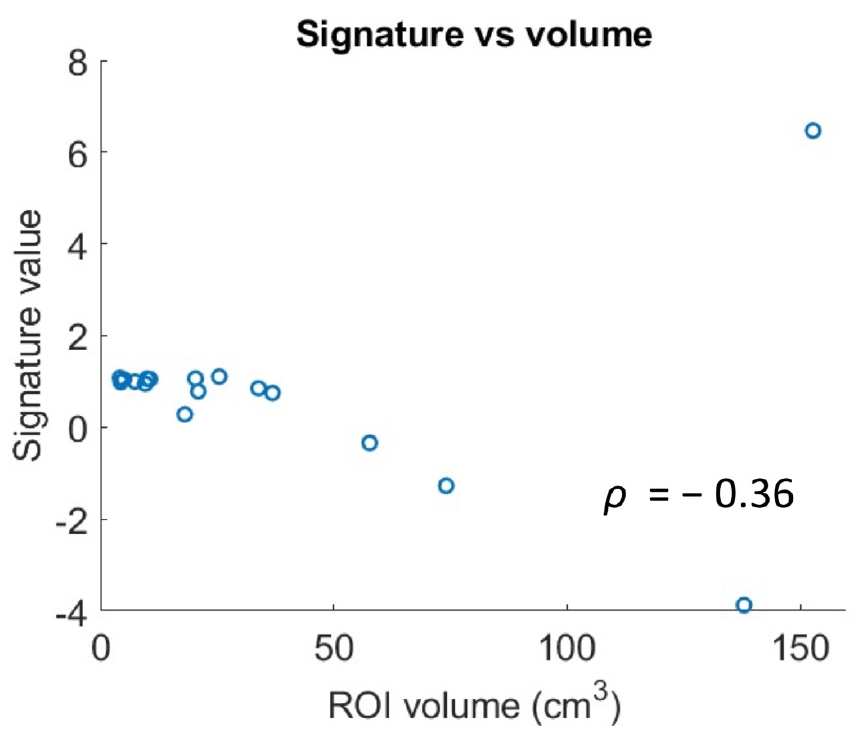
Figure 5. Scatterplot representing the correlation between the volume of the Region Of Interest (ROI) and the radiomic signature.